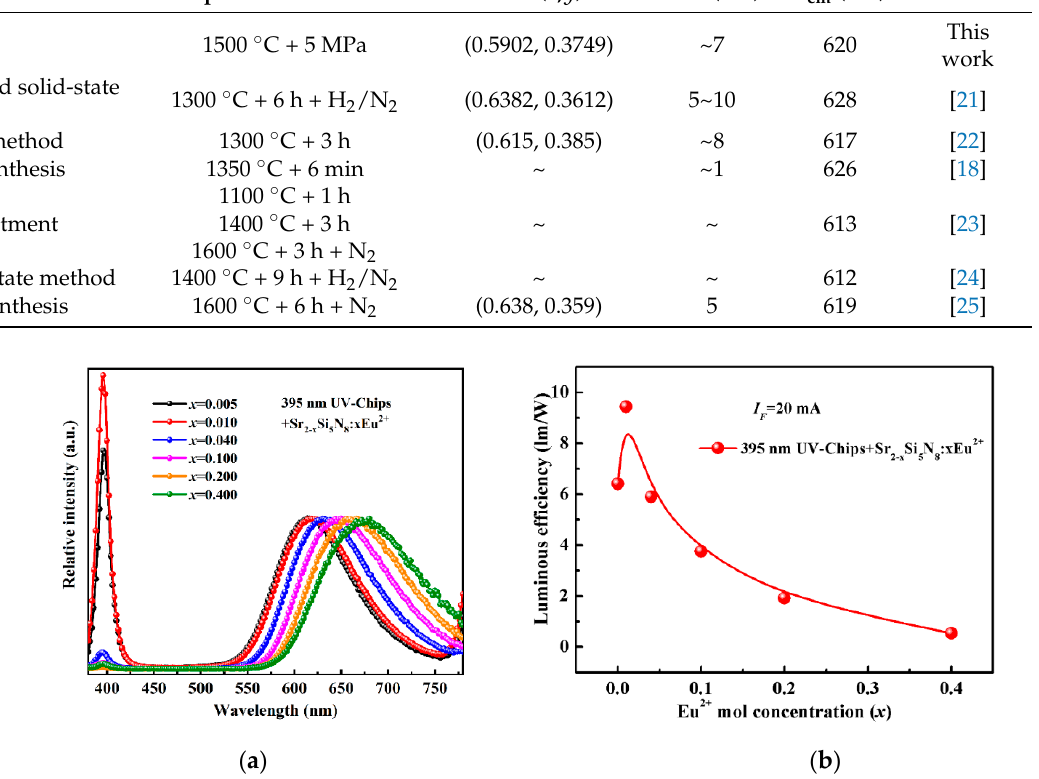
Table 1. The performance of the Sr 2 Si 5 N 8 : Eu 2+ phosphors fabricated by various methods. Preparation